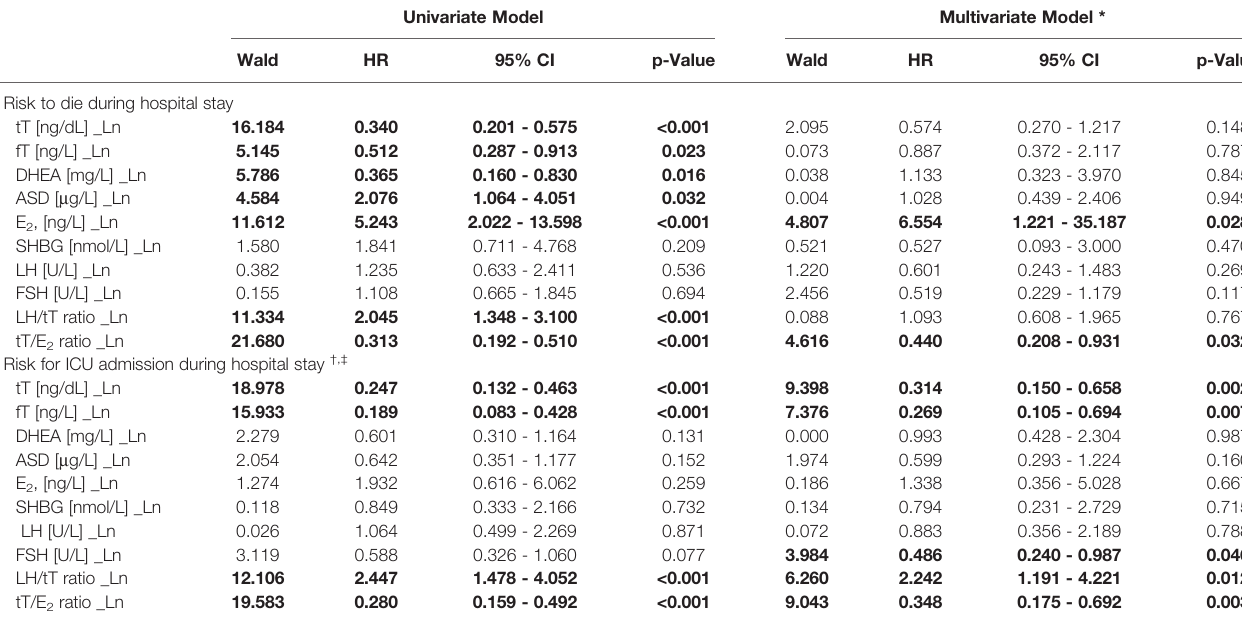
TABLE 4 | Logistic regression analysis of sex hormones and the risk do die or admission to ICU during hospital stay in men. Univariate Model Multivariate Model *